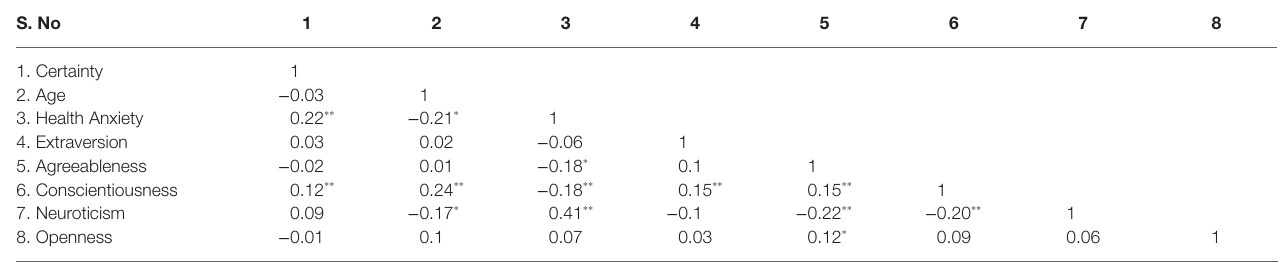
N for all variables = 375. ∗ p < 0.05; ∗∗ p < 0.01.